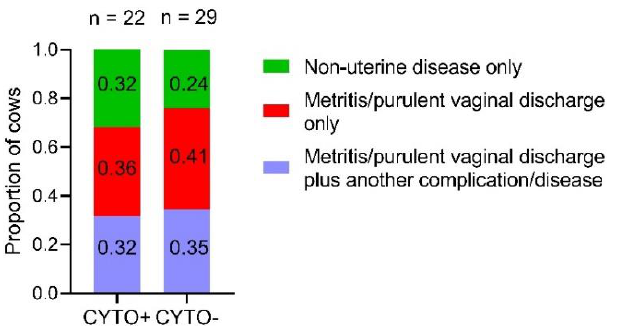
Figure 3. Proportions of cows with non-uterine disease only, metritis/purulent vaginal discharge only and metritis/purulent vaginal discharge plus another complication/disease between unhealthy cytological endometritis-positive (CYTO+) and unhealthy cytological endometritis-negative (CYTO − ) multiparous Holstein cows. Out of the 119 studied cows, 51 (43%) had postpartum complications and/or disease.